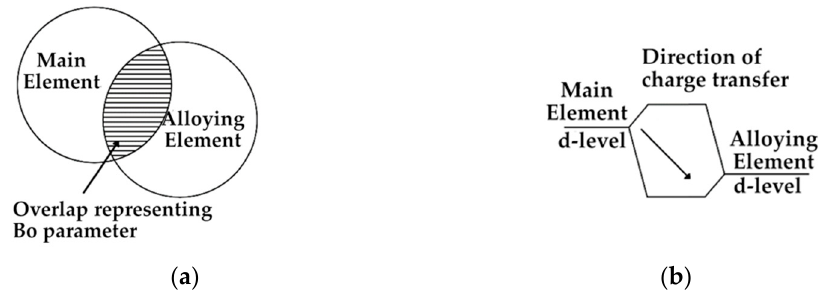
Figure 1. Graphical representation of Bo ( a ) and Md ( b ) parameters.